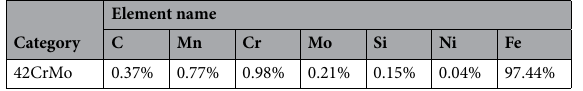
Table 1. Chemical composition of 42CrMo steel.